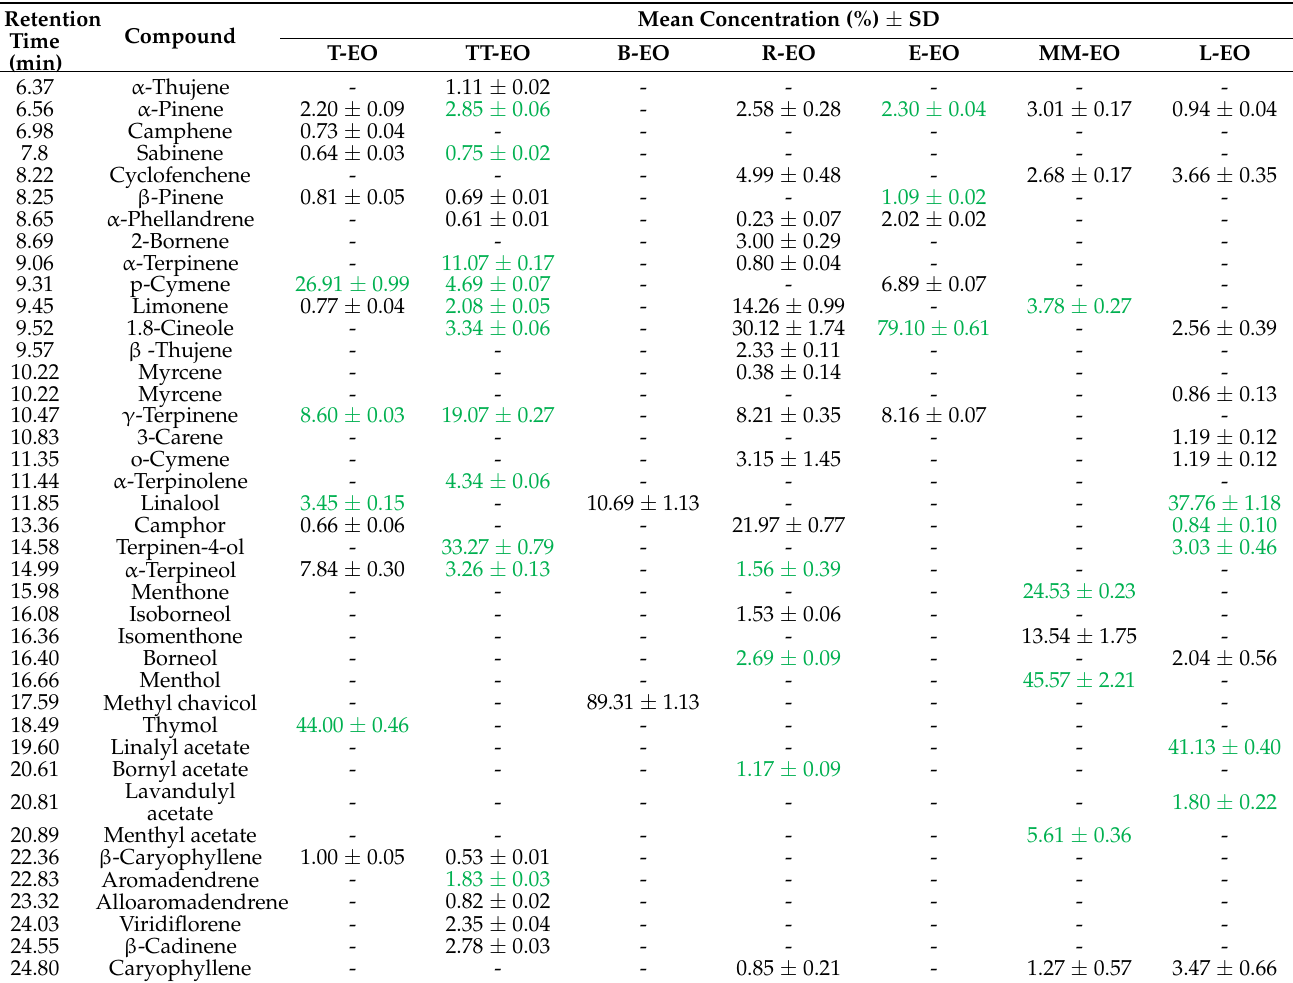
Table 1. The content (% ± standard deviation) of compounds in essential oils. T-EO, thyme oil; TT-EO, tea tree oil; B-EO, basil oil; R-EO, rosemary oil; E-EO, eucalyptus oil; MM-EO, menthol mint oil; L-EO, lavender oil. Dashes (-) indicate the compounds not presented in the specific EO. The components in line with Polish Pharmacopoeia XI standards are marked in green